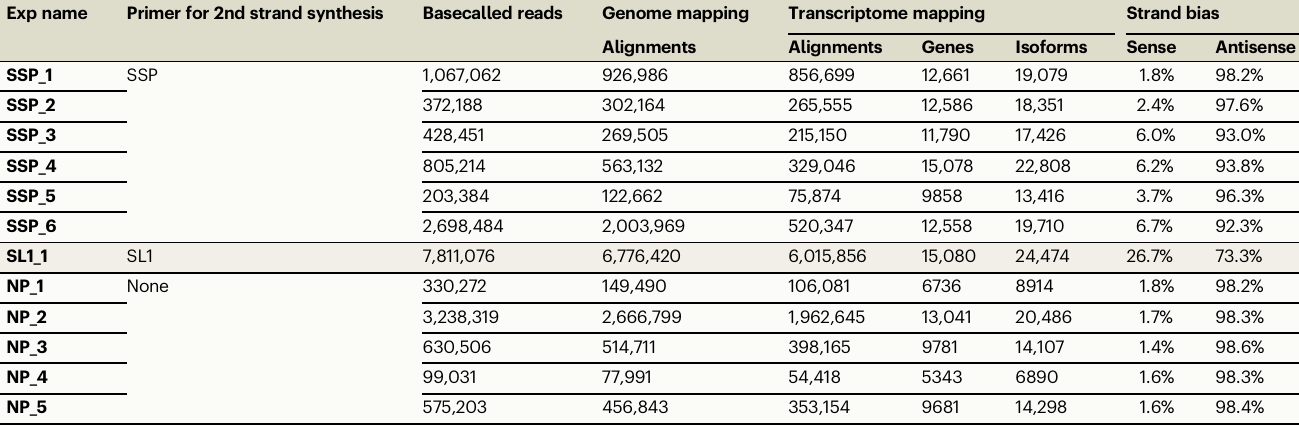
Table 1 | Minion direct-cDNA runs included in this